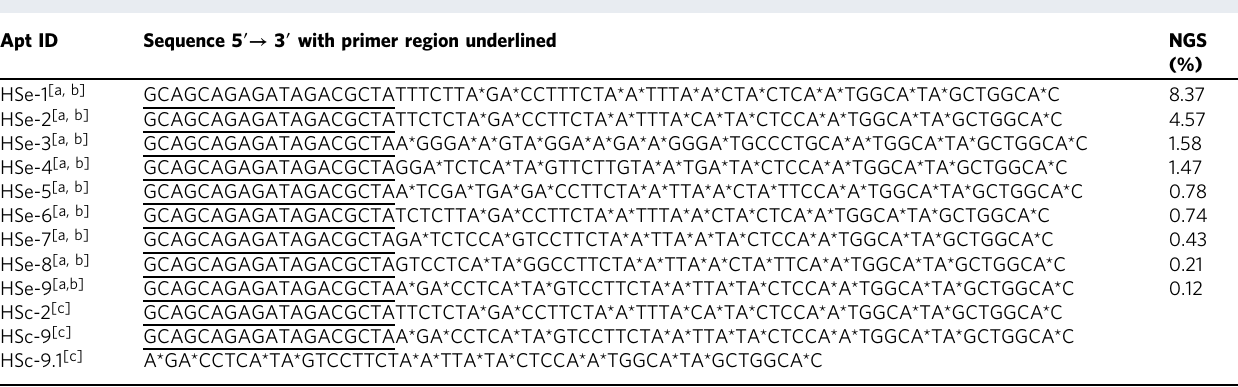
Table 3 List of the most abundant aptamer sequences obtained after SELEX against Hsp70. Apt ID Sequence 5 ′ → 3 ′ with primer region